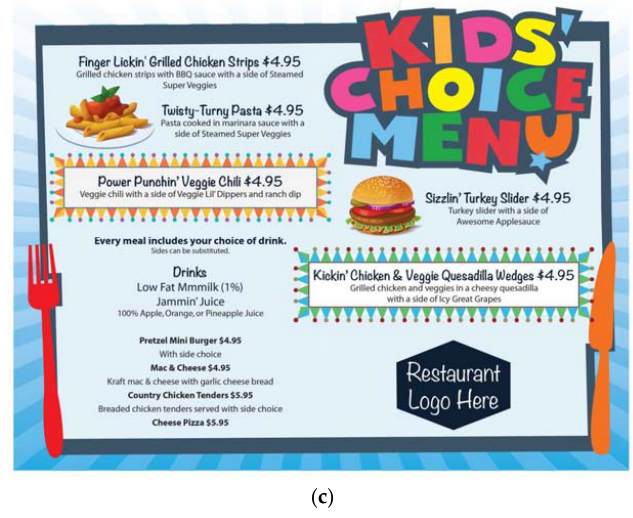
Figure 2. Example kids menus. ( a ) Original menu; ( b ) New menu from Menu ‐ only condition; and, ( c ) New menu from Menu ‐ plus condition.